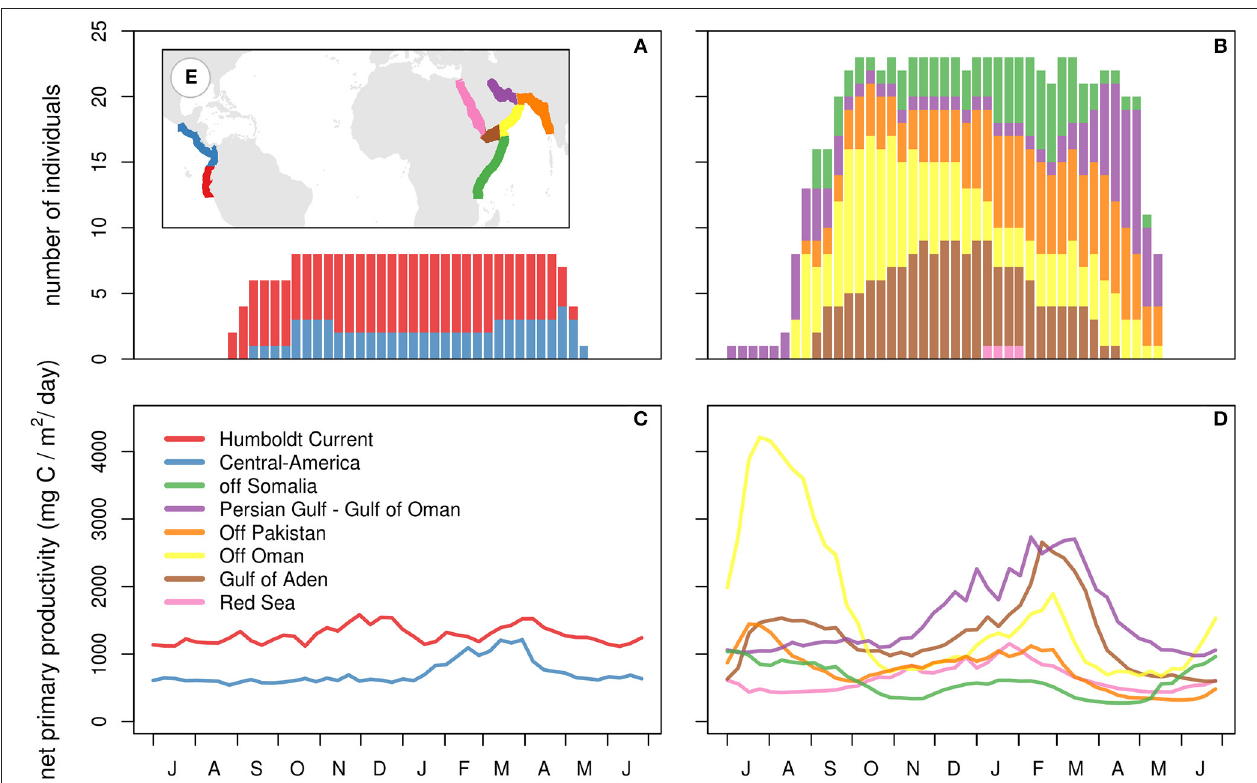
FIGURE 5 | Number of tracked red-necked phalaropes (A,B) and mean net primary productivity (C,D) in each of two sectors in the Pacific (A,C) and six sectors in the Arabian Sea and adjacent areas (B,D) ; see (E) for configuration of the